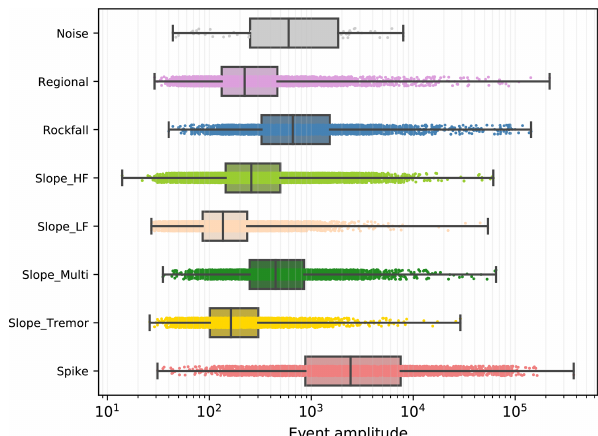
Figure B16. Box plots showing the distribution of amplitudes for each event class.